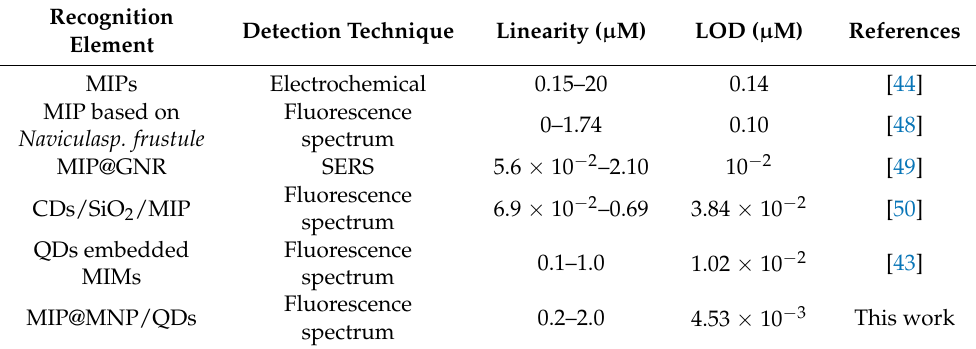
Table 2. Comparison of the performance of the MNP/QD@MIPs sensor with previously reported MIPs-based sensors for the determination of lysozyme.